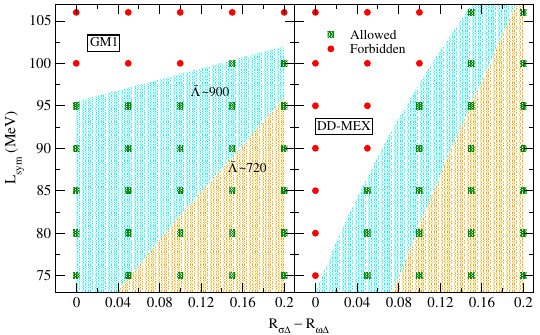
Figure 3. Coupling parameter space range of R σ ∆ − R ω ∆ for which constraints from nuclear physics experiments as well as astrophysical constraints are fulfilled. Here, we have varied R σ ∆ in the range of [1 . 10 − 1 . 30]. The shaded regions (cyan −→ ˜ Λ ∼ 900 and orange −→ ˜ Λ ∼ 720) are the allowed parameter space which fulfill both the terrestrial and astrophysical